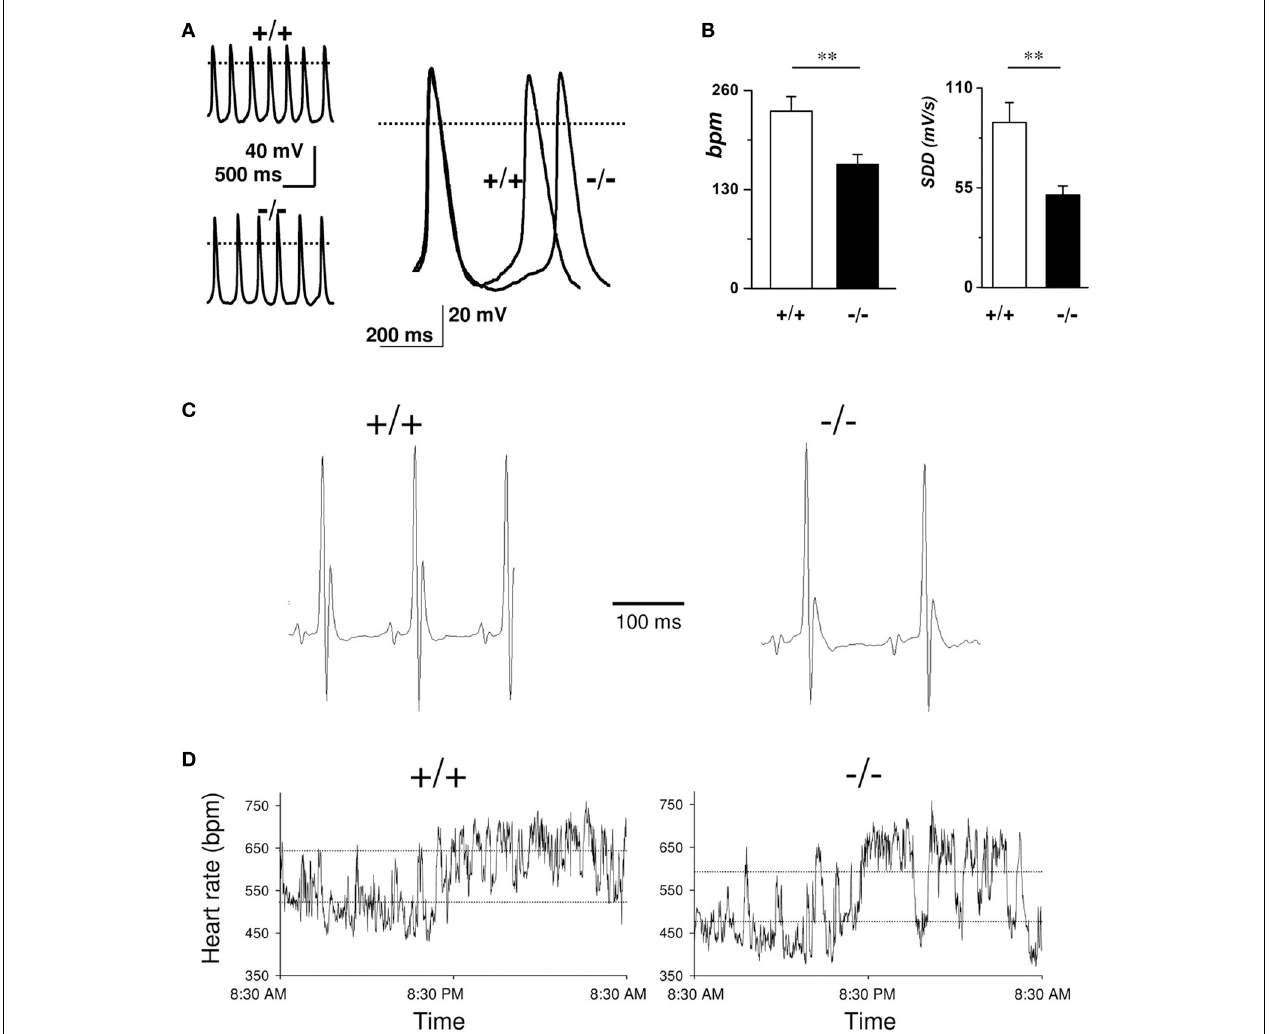
FIGURE 3 | Role of T-type VGCCs in cardiac automaticity. (A) Representative sweeps of spontaneous action potentials obtained from SAN cells from WT (upper left trace) and Ca v 3.1 − / − mice (lower left trace). Right panel: Superimposition of typical action potentials from a WT and from Ca v 3.1 − / − SAN cell. (B) Histograms of the average bpm value and the slope of the diastolic depolarization (SDD).